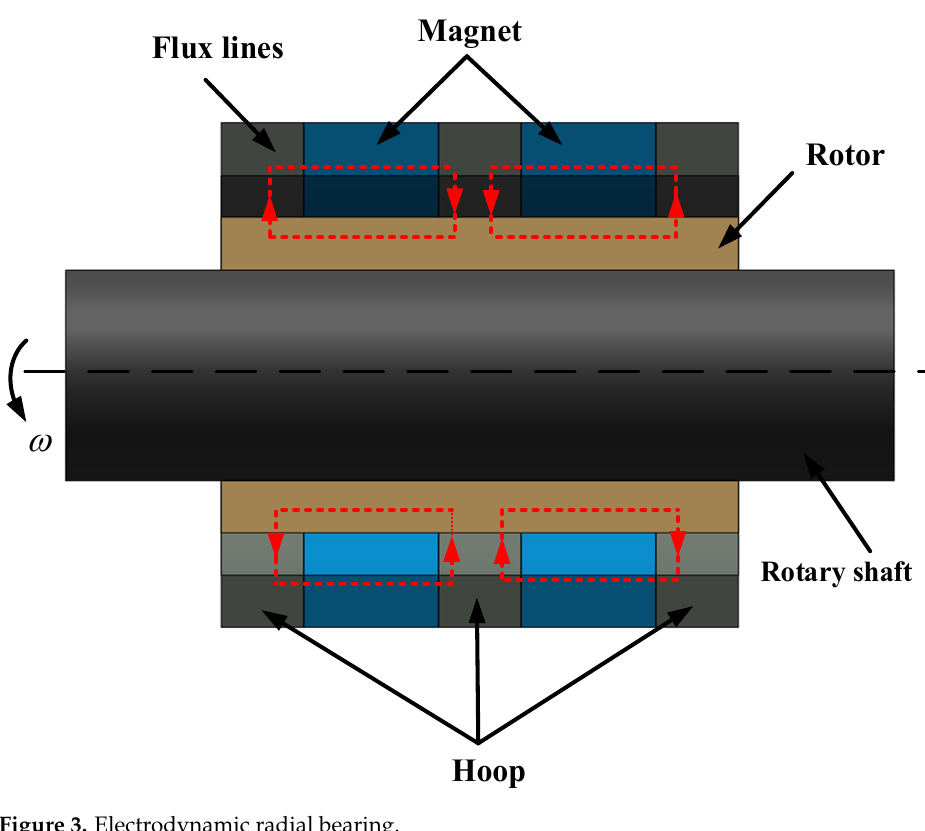
Figure 3. Electrodynamic radial bearing.